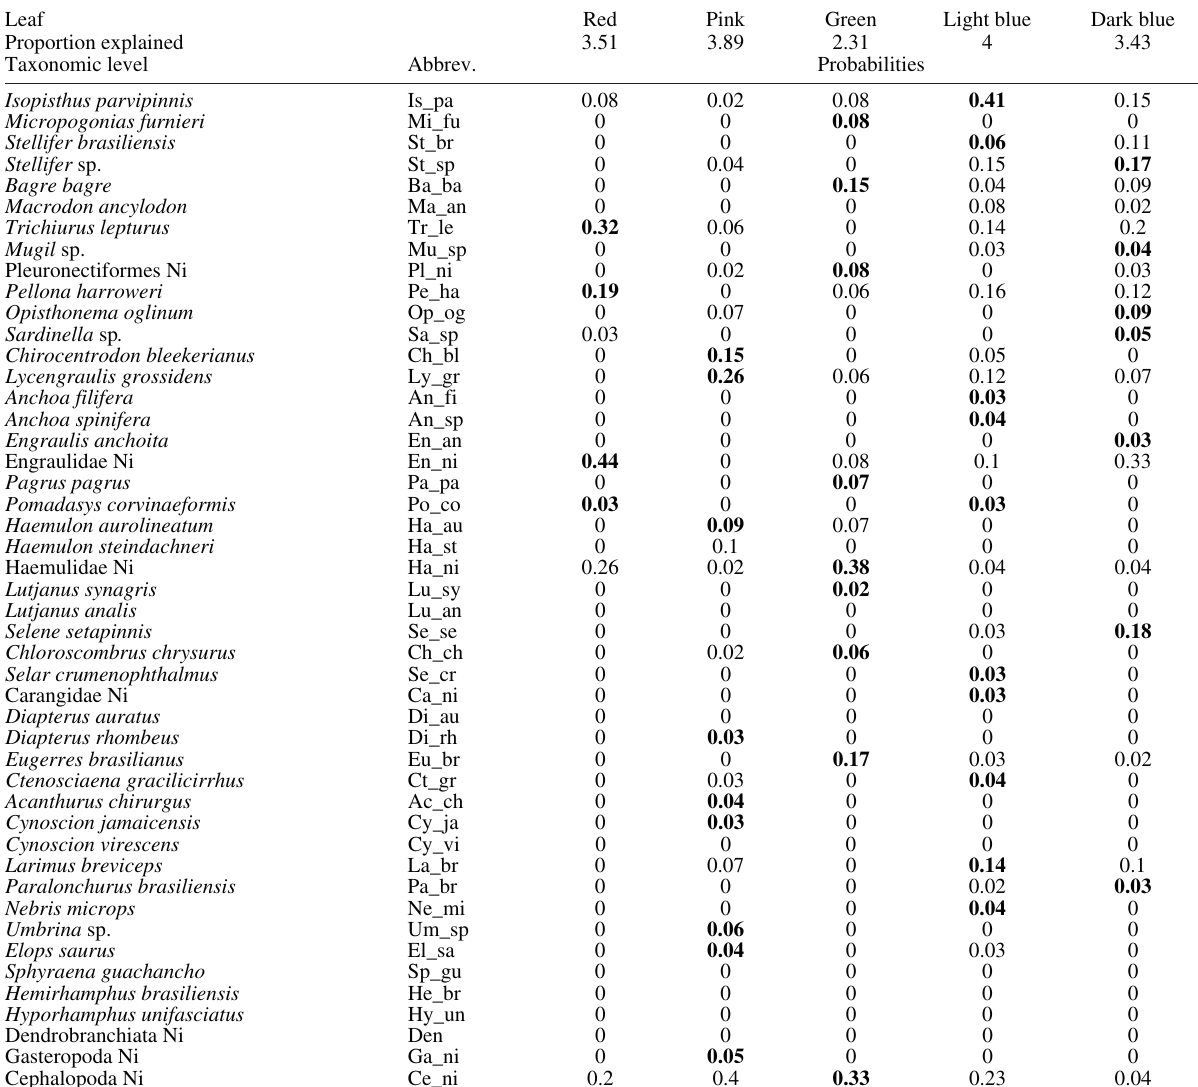
Table 2. – Relative presence of Guiana dolphin prey as a function of changes in climate conditions for each group formed by the regression tree on the southern Atlantic coast of Brazil. See the meaning of the colour groupings in the legend of Figure 2A. Values in bold represent the highest probability of prey species occurrence from the regression tree grouping.